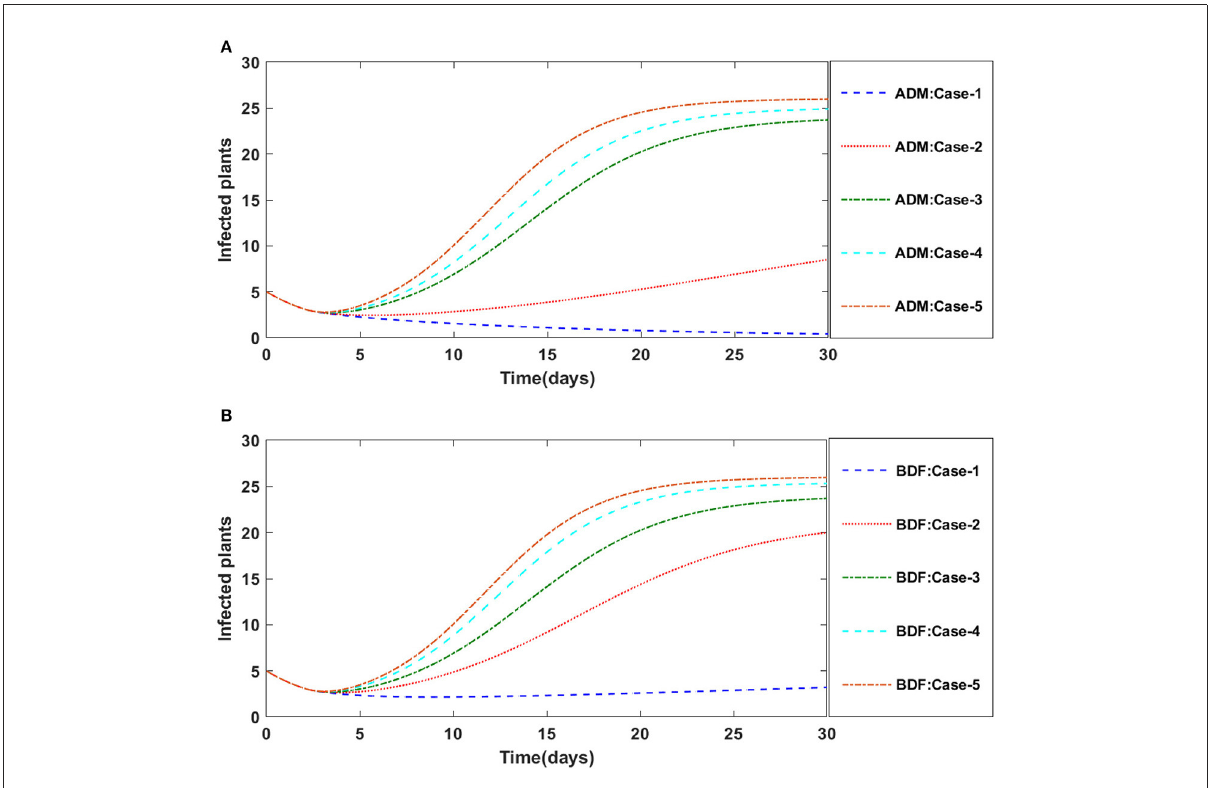
FIGURE19 (A) Dynamics of infected plants for the varition in (cid:127) using ADM for model B1. (B) Dynamics of infected plants for the varition in (cid:127) using BDF for model